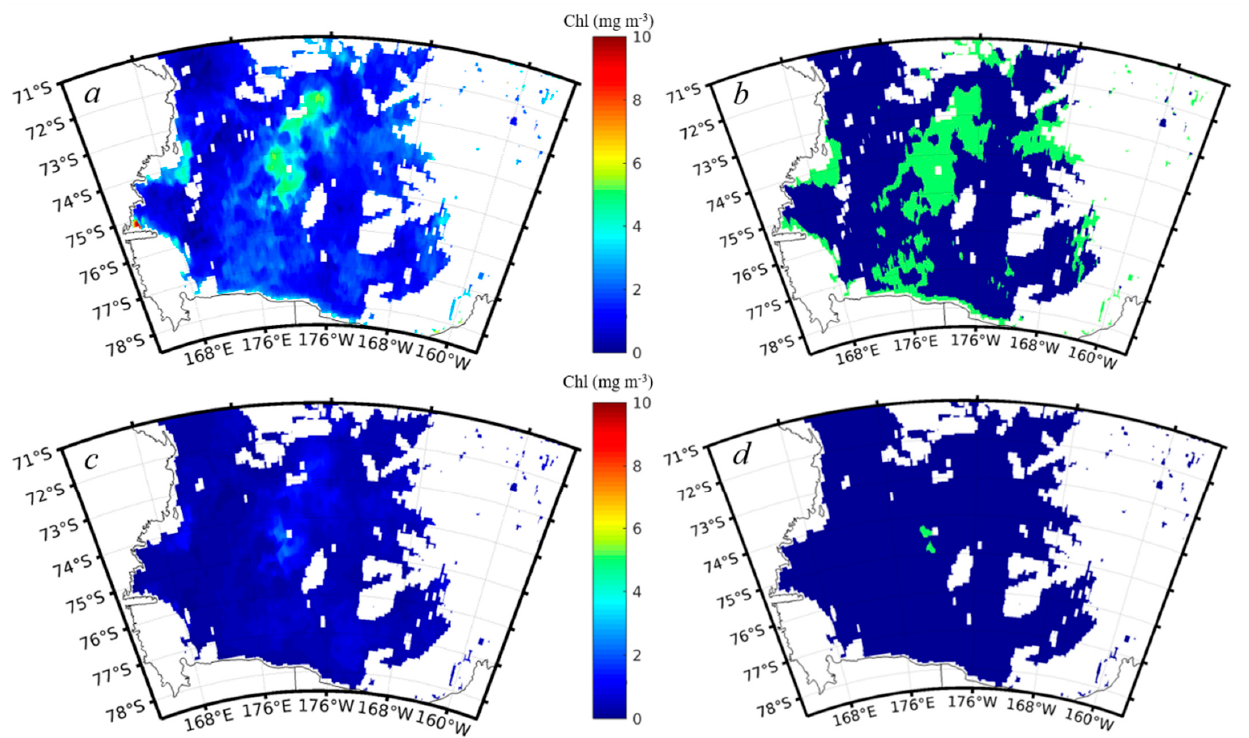
Figure 1. Comparison of the spatial distribution of the phytoplankton blooms on 12–18 February 2005, identified using the locally-tuned Chl algorithm ( a , b ) and the NASA standard Chl algorithm ( c , d ), respectively. Note that the green patches in ( b , d ) are the bloom masks corresponding to the Chl data in ( a , c ), and blue patches are observations without blooms.